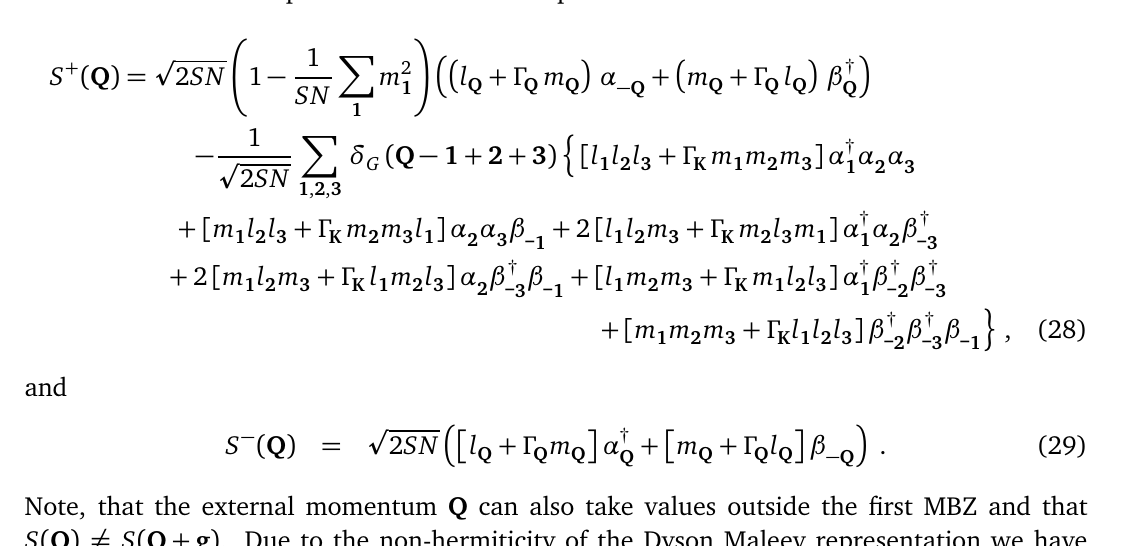
Figure 9: Illustration of the sign structure of the factor Γ = + 1 for K ∈ Z − for K ∈ Z + or Γ K